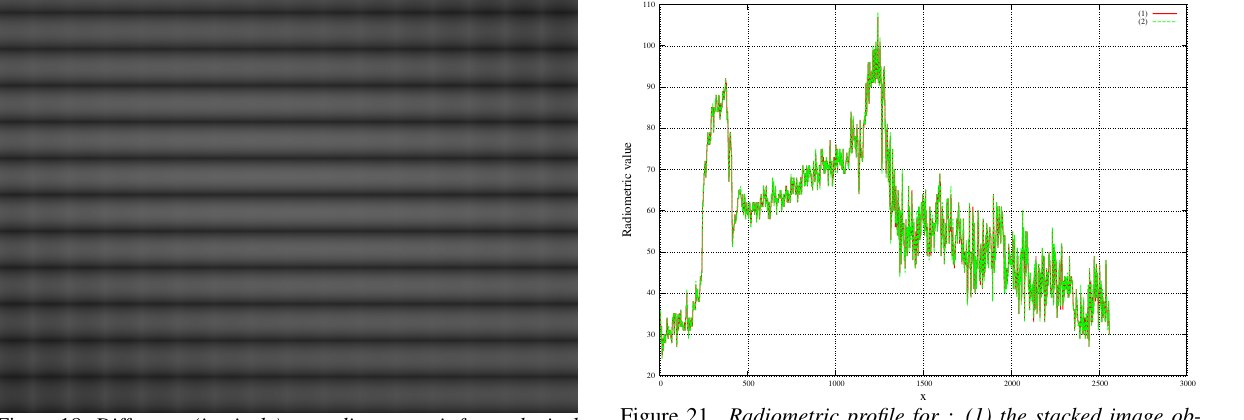
Figure 18. Difference (in pixels) according to x axis for each pixel between the projected point obtained by the precise mapping and the projected point obtained by the bilinear function between the 1 st and the 10 th image : Diff max = 0 . 0146 .